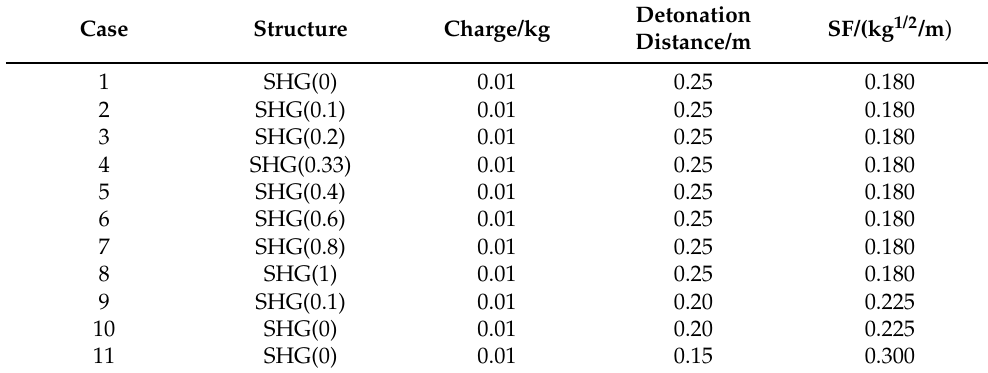
Table 5. Calculated